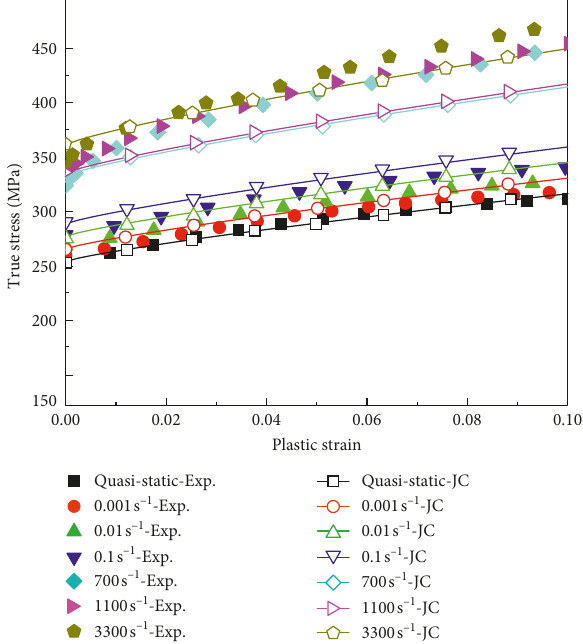
Figure 7: Comparison between predicted results of the JC model and experimental results at different strain rates.